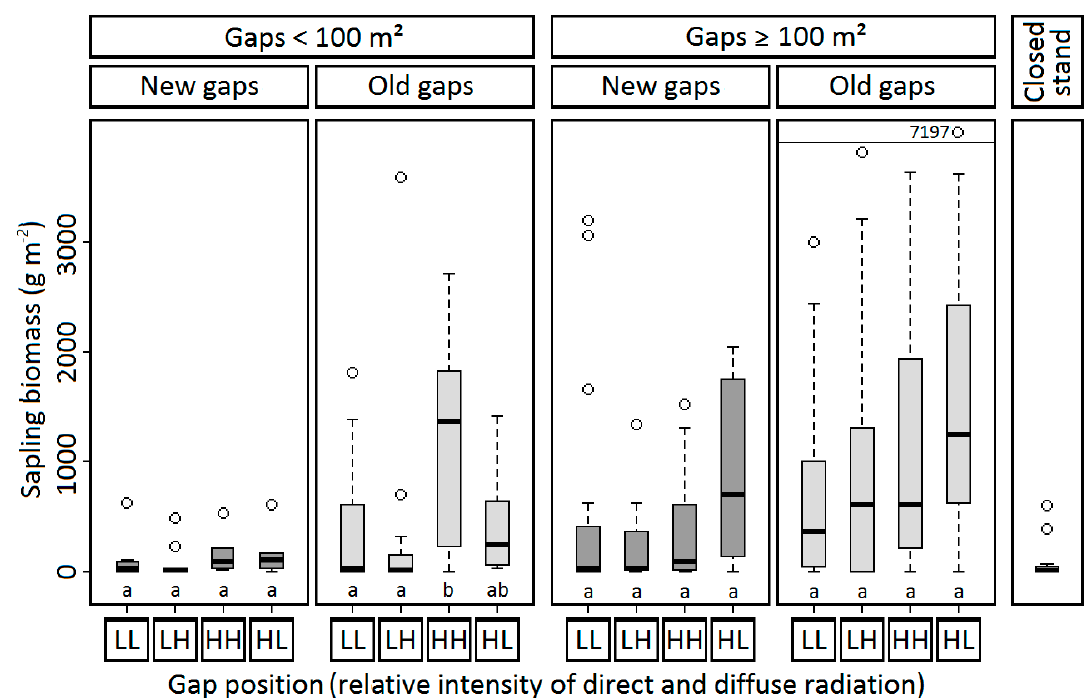
Figure 5. Estimated sapling biomass in squares at di ff erent position in a gap that formed between 2003 and 2013 (new gaps; dark grey) or prior to 2003 (old gaps; light grey) presented for small ( < 100 m 2 ) and medium-sized gaps ( ≥ 100 m 2 ). The four gap positions are characterized by the availability of di ff erent relative intensities of direct and di ff use radiation (high = H, low = L; first letter for direct and second for di ff use radiation; see Table 1 and Figure 1) following Diaci [38]. The density values of closed-canopy plots are displayed at the right for comparison (32 belt transects á 13 m 2 area). Box-whisker plots with median (thick line), 25-and 75-percentiles (box) and extremes not exceeding the 1.5fold of the interquartile range (whiskers). Dots indicate extreme data points beyond 1.5 times the IQR. Di ff erent letters below the boxes indicate significant di ff erences between the gap positions within gaps of a certain size and age class (linear hypothesis testing).